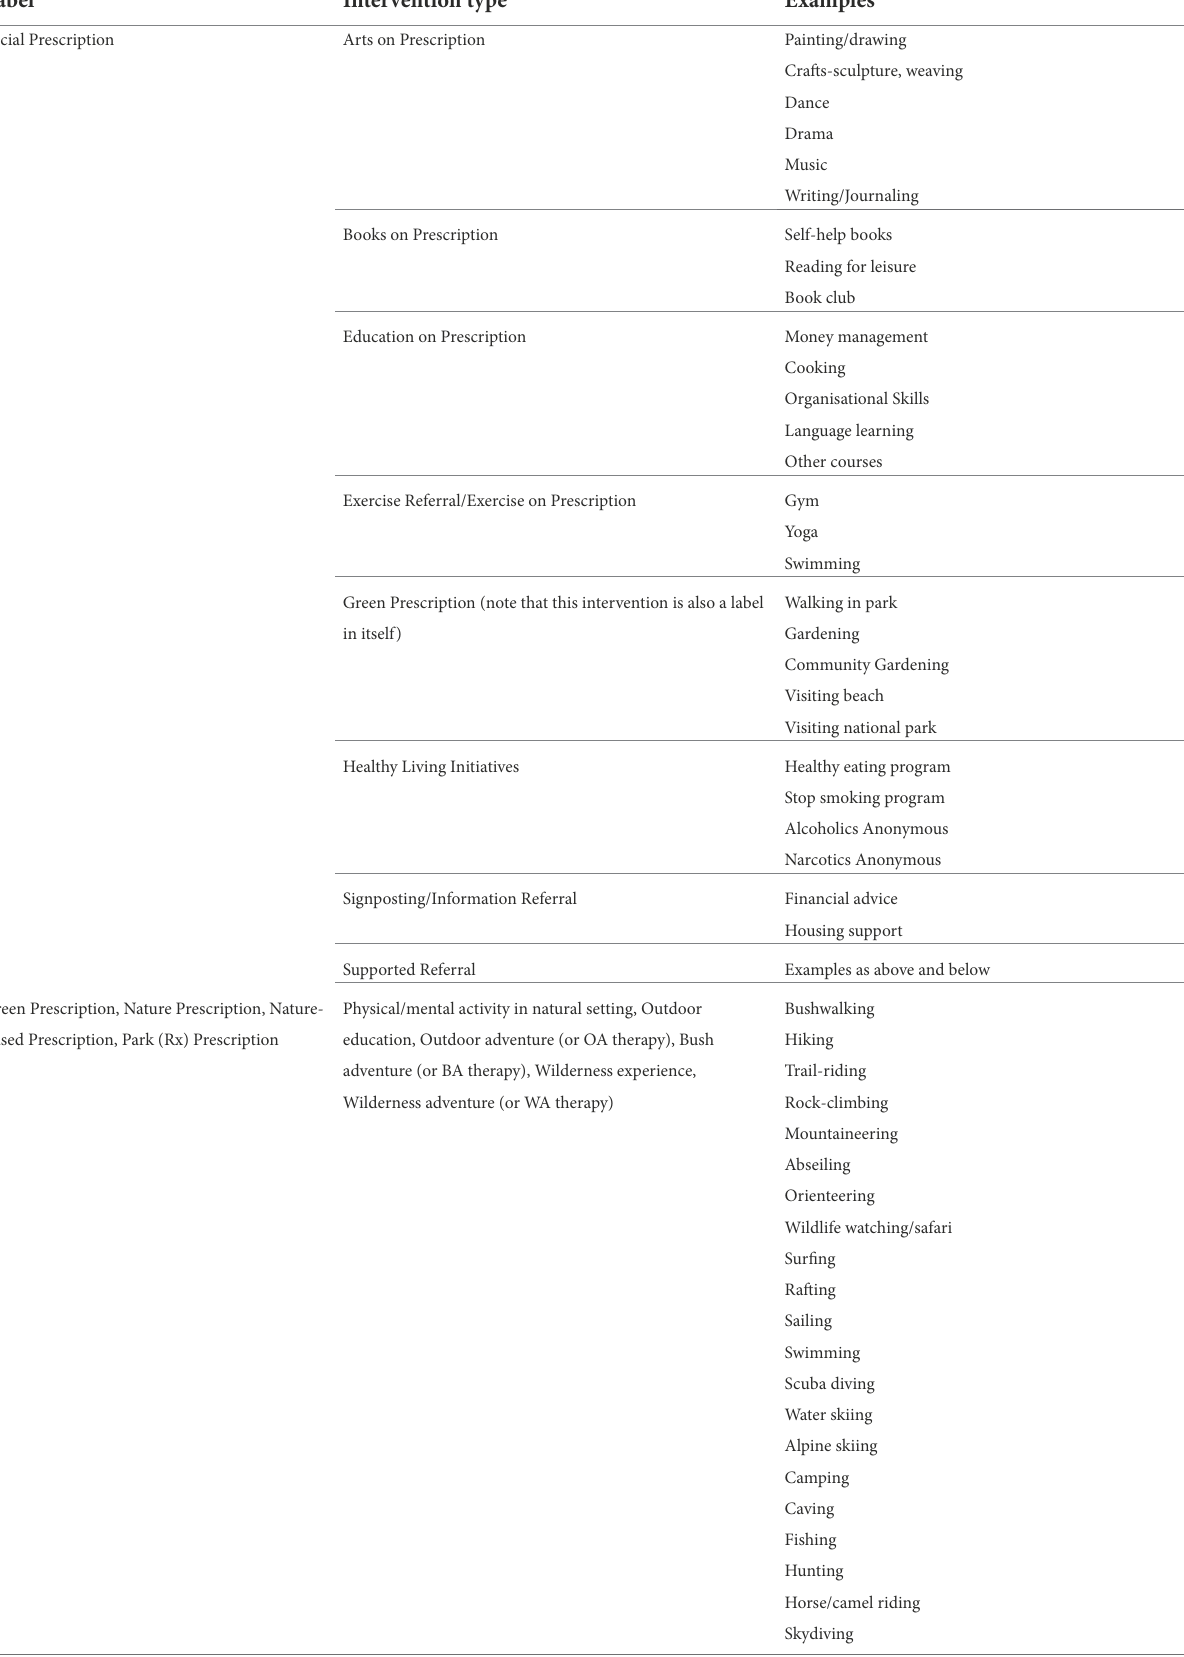
TABLE 1 Social and green prescription labels, intervention types and examples.